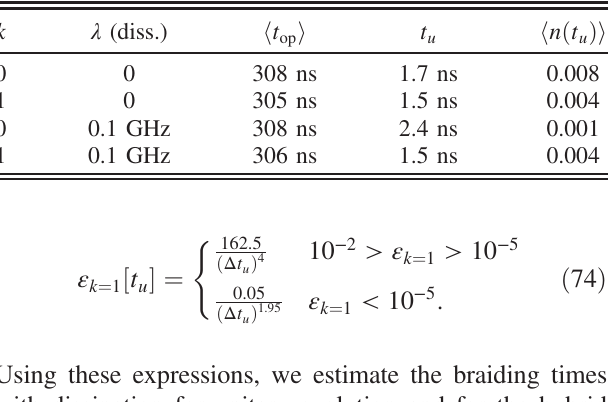
TABLE I. Braiding time using the hybrid protocol for the system discussed in Sec. VI with Δ ¼ 10 GHz and temperature T ¼ 0 . 001 Δ . The column labels are as follows: the smoothness of the time evolution of the system Hamiltonian ( k ¼ 0 , 1), the system-bath coupling λ ¼ 0 (no dissipation) or λ ¼ 0 . 01 Δ (dis- sipation), the average braiding time h t , the corresponding op i unitary time t , and the average number of recovery steps needed u to complete the braid, h n ð t . The above values assume no u Þi measurement error and no error from transitioning to excited states with energy O ð E above the ground state. We use the M Þ 0 . 2 ns and t 100 ns, and then choose t estimates t to u flip ¼ meas ¼ > t minimize Eq. (72), subject to the constraint that t . u th